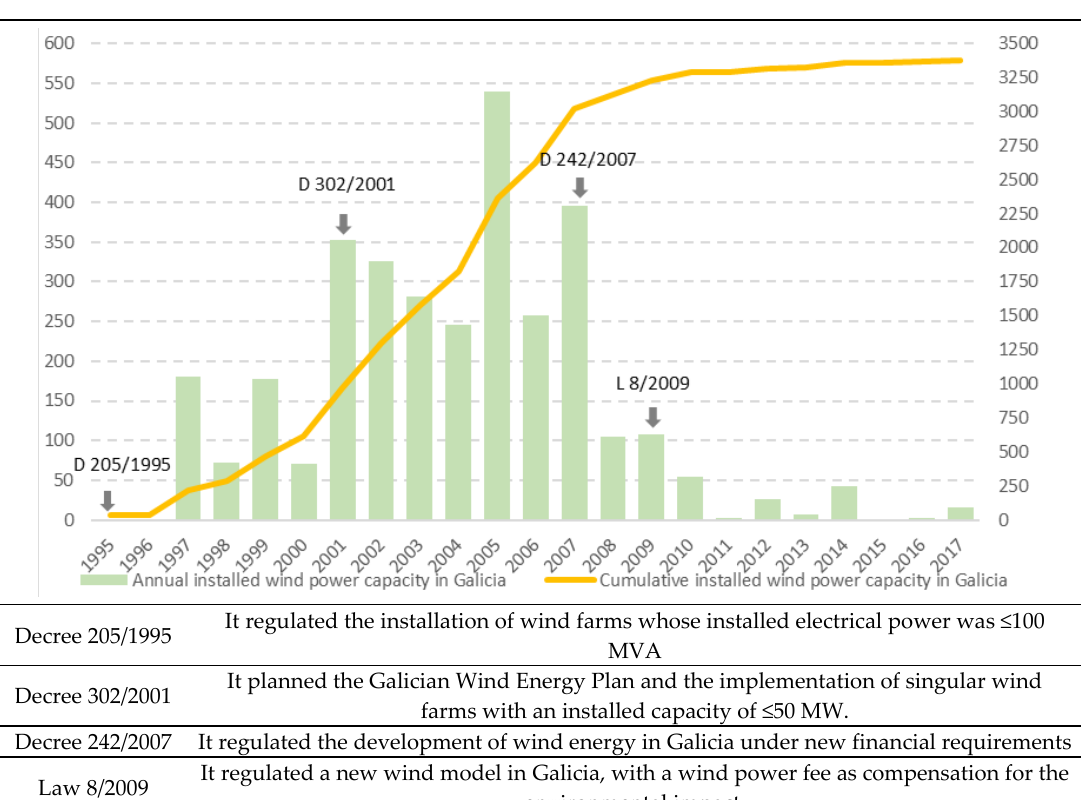
Figure 5. Installed wind power and principal legislation. Galicia (1995 – 2017) elaborated from [63,68].